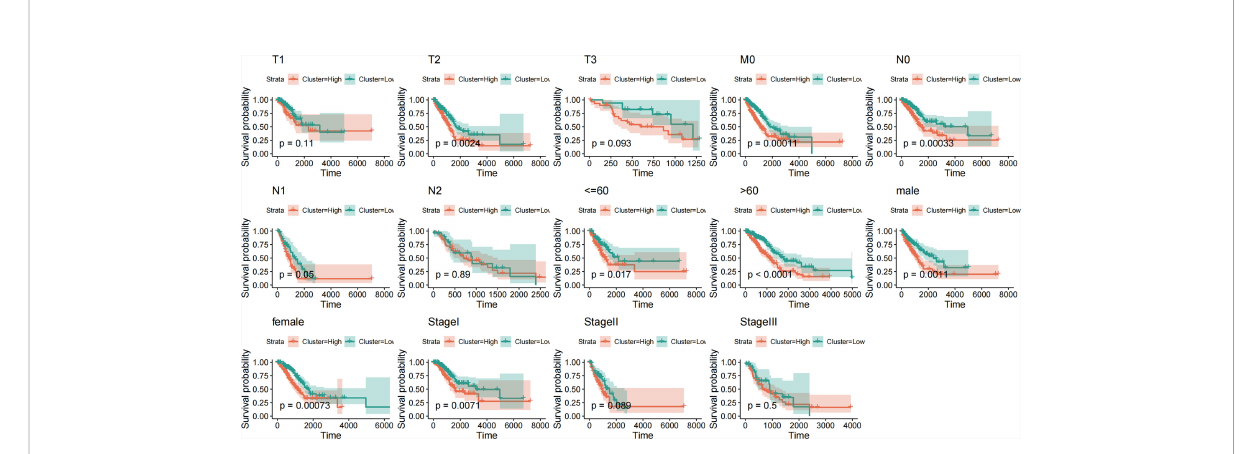
FIGURE 10 Prognostic ef fi cacy and stability assessment of the risk score